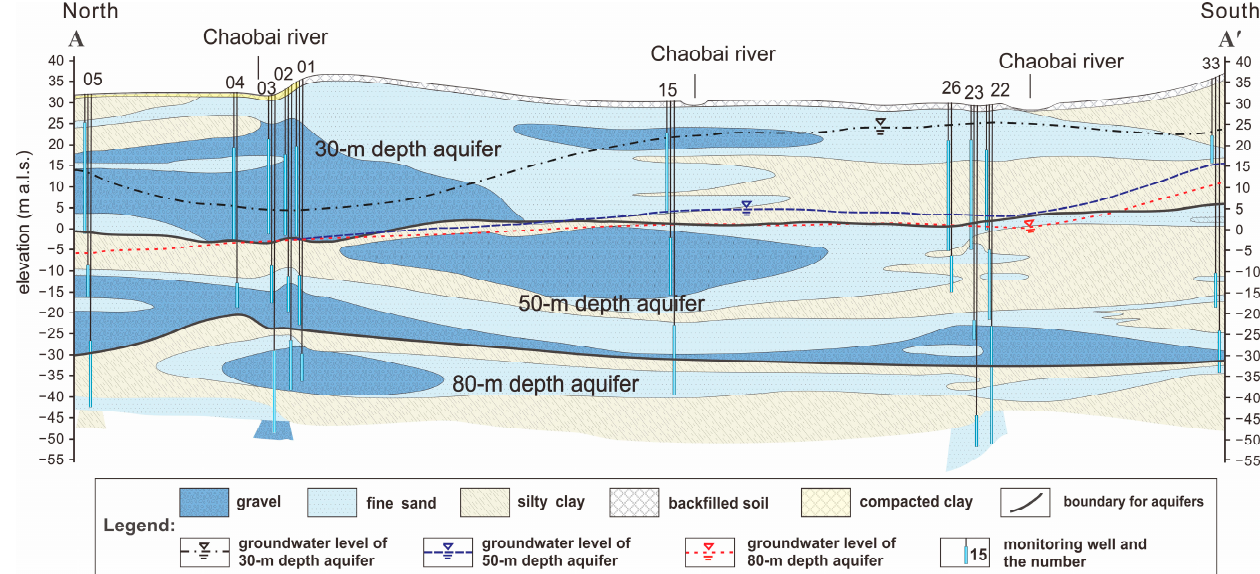
Figure 2. Hydrogeology section A-A ′ in Figure 1 along the Chaobai River, showing the screened intervals of the monitoring wells. The groundwater levels are shown for monitoring results in September 2007 [15]. The Chaobai River was dried before the reclaimed water transfer, so the surface water was not shown.